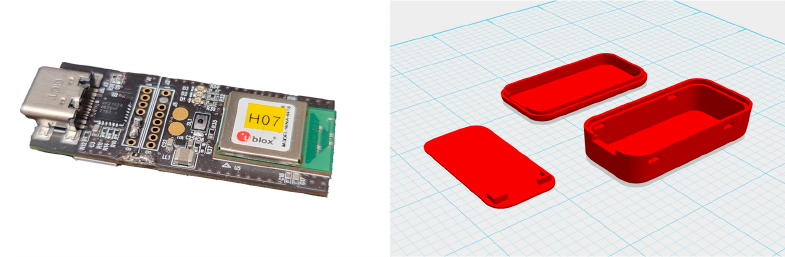
Figure 7. ( Left ) Printed circuit board. ( Right ) Device case.